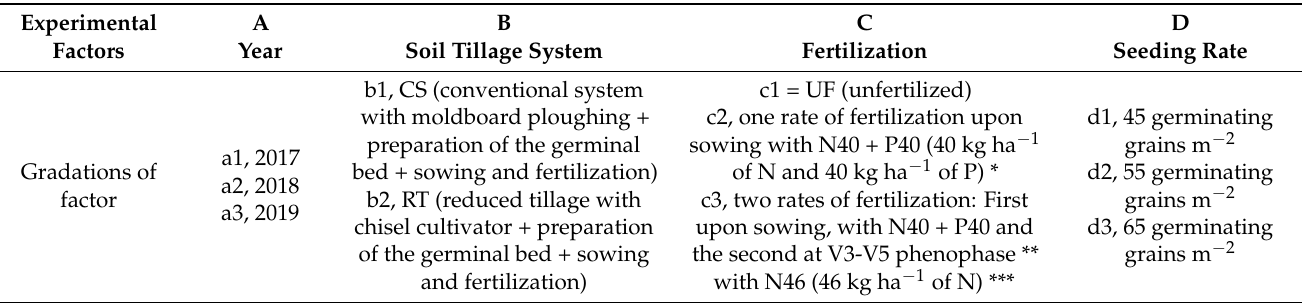
Table 3. The experimental factors with